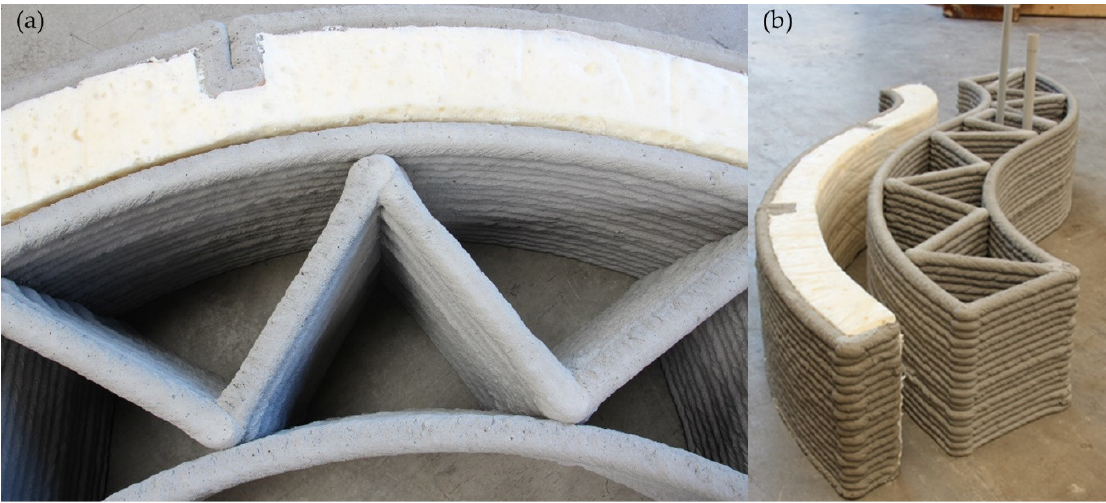
Figure 3. Printed demonstration object with integrated insulation and piping system printed at the Institute of Structural Concrete, RWTH Aachen University: ( a ) top view, ( b ) side view.